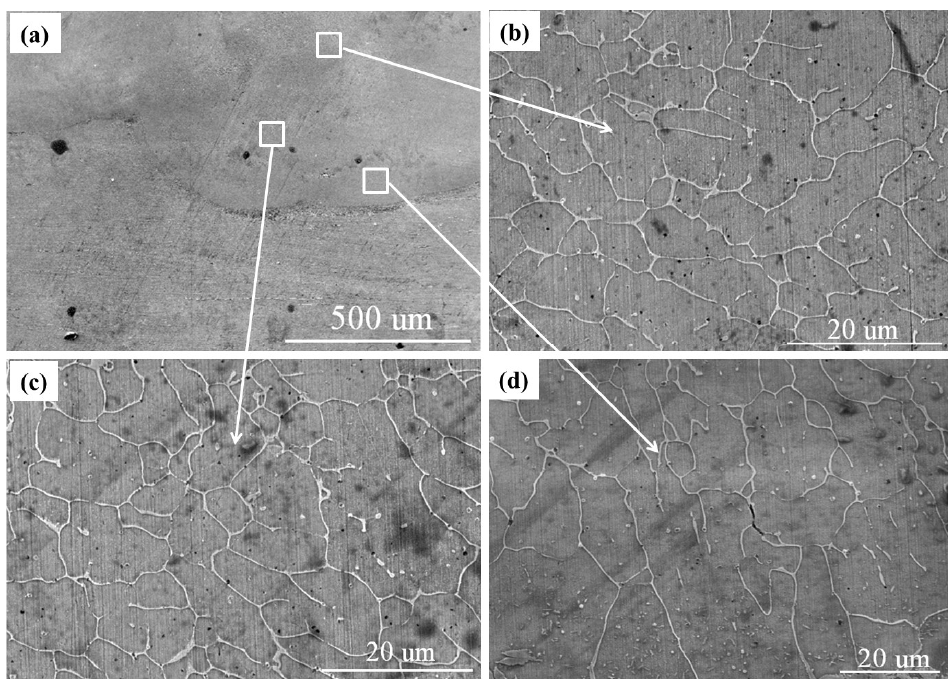
Figure 4. Cross-sectional microstructure of the AlCoCrFeNi/WC coating by laser cladding: ( a ) microstructure of the cladded coating; ( b – d ) magnification of the top, middle and bottom regions, respectively.